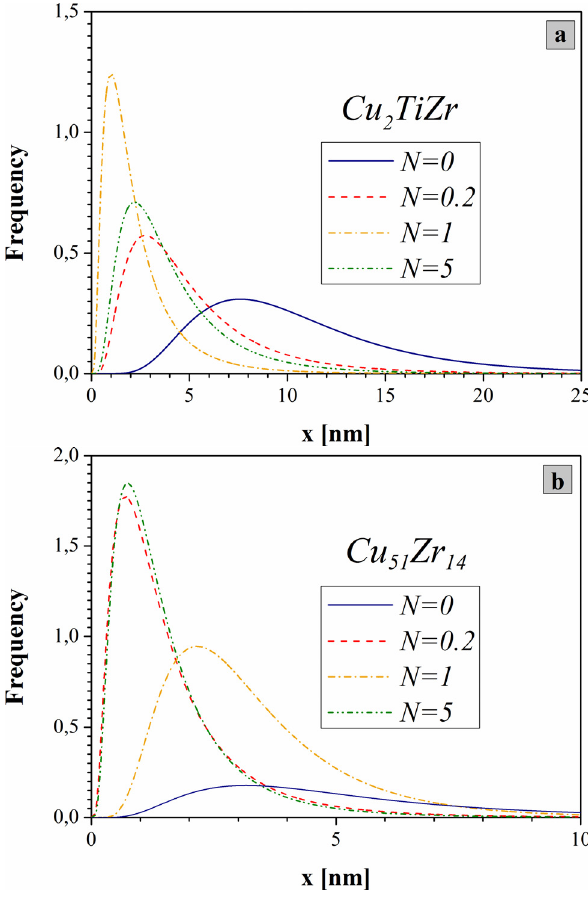
Figure 6: Crystal size distributions determined by CMWP fitting of the (a) Cu 2 ZrTi and (b) Cu 51 Zr 14 phases for the different deformed